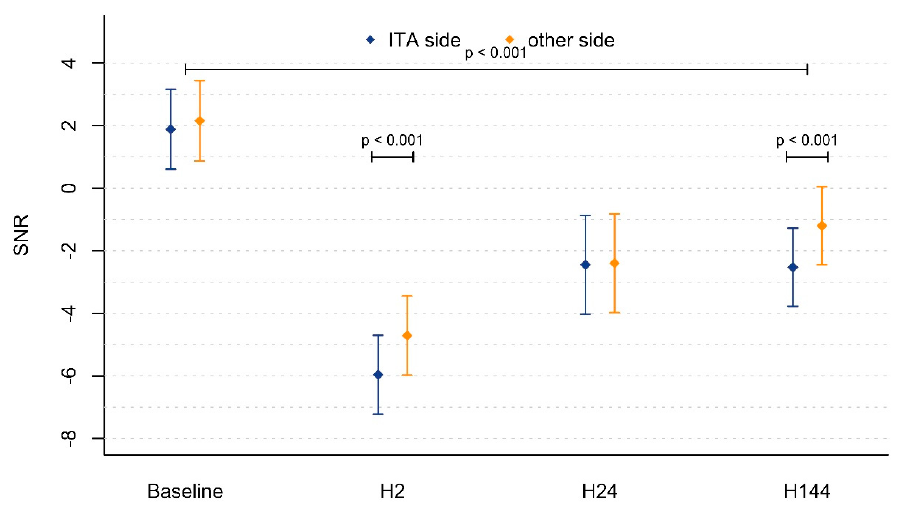
Figure 3. SNR values before (baseline) and two hours (H2), one day (H24) and six days (H144) after surgery. Means and 95% confidence intervals are shown. Table 1. Signal-to-noise ratio (SNR) in arbitrary units. 95% CI: 95% confidence interval. SNR was calculated before (BL) and two hours (H2), one day (H24) and six days (H144) after surgery. ITA side: side of the chest wall with preparation of the internal thoracic artery; other side: side of the chest wall without ITA preparation; p 1 for comparison against baseline; p 2 for the di ff erence between both sides.